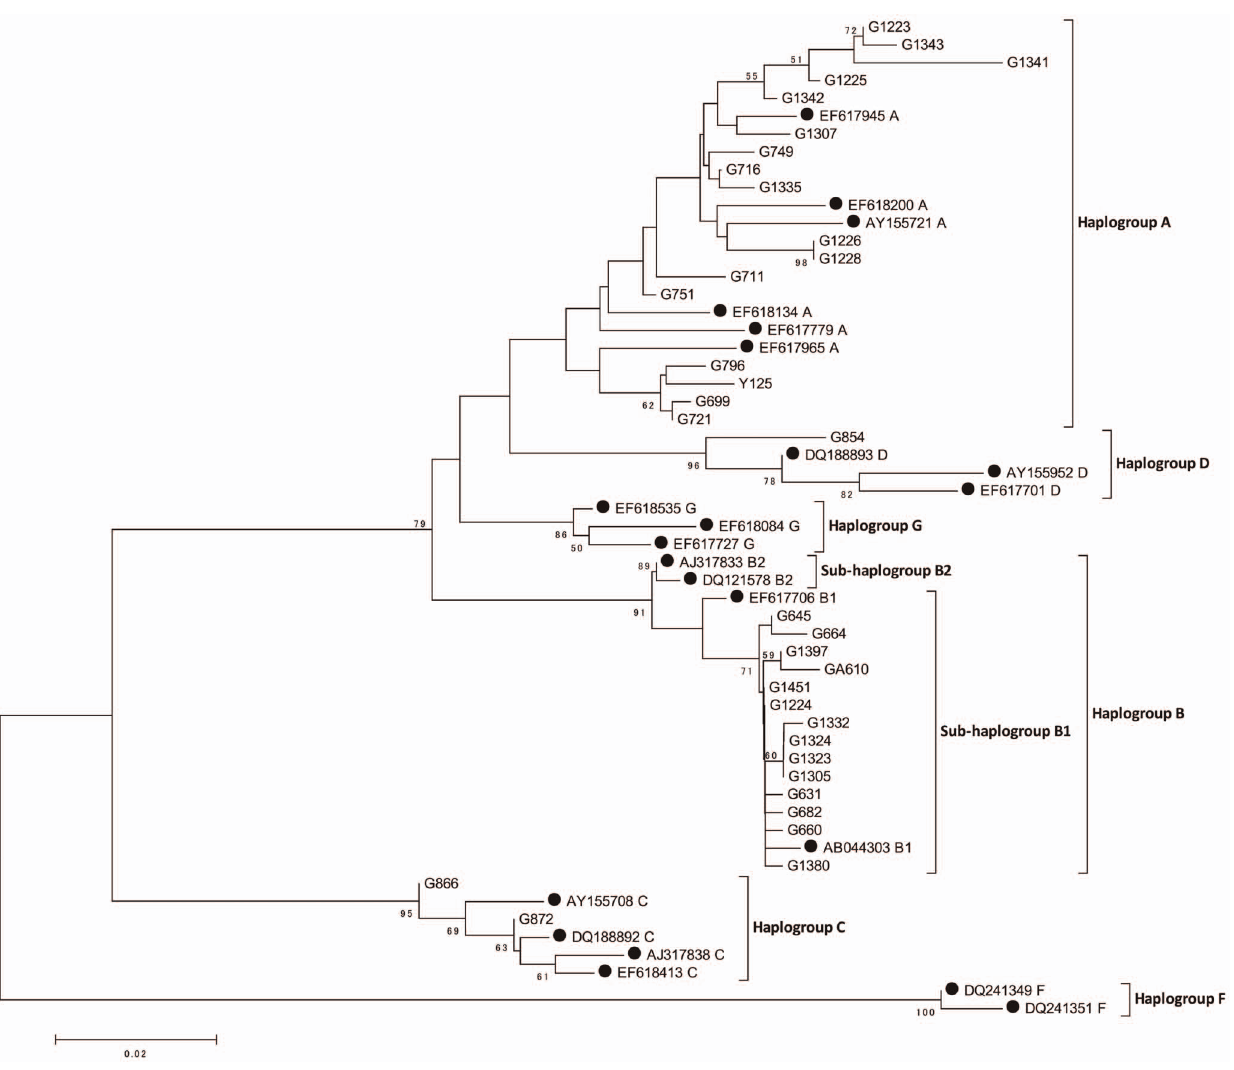
Figure 1. NJ tree based on the D-loop sequences of goats: Kimura’s 2 parameter model [ 35 ] with the gamma distribution ( a =0.22) was used in estimating genetic distances. Branch lengths are proportional to the number of nucleotide substitutions. The markhor was used as an outgroup. Nodal numbers indicate bootstrap probabilities (10,000 replications).